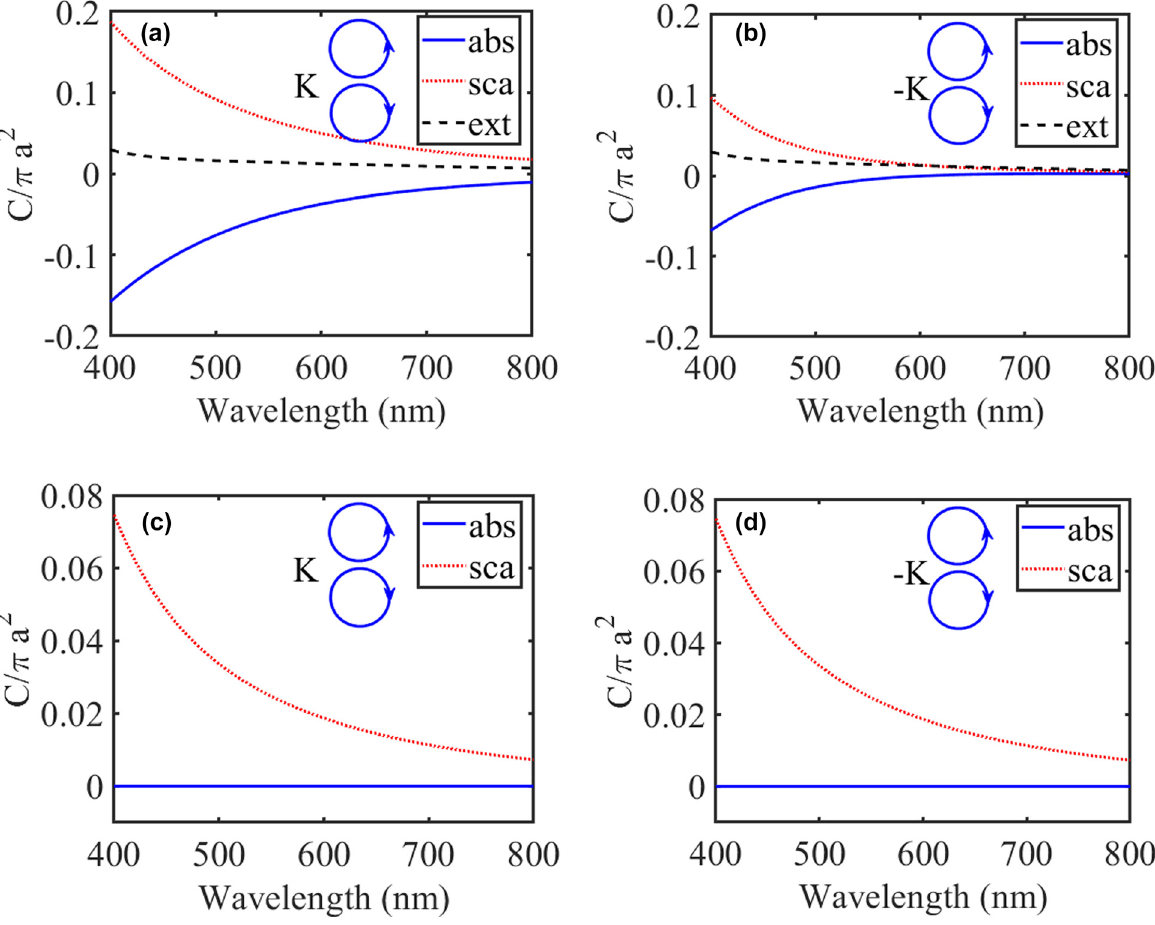
Figure4: (a)Normalizedextinction(blackdashlines),scattering(reddotlines),andabsorption(bluelines)crosssectionsofthePT-symmetric nanosphereswithoutchirality,i.e., δ = 0 . 5and κ = 0(a)and(b),andchiralnanoparticleswithoutgainandloss,i.e., δ = 0and κ = 0 . 05(c)and (d). The optical cross sections of LCP and RCP waves are the same when they are incident from the same